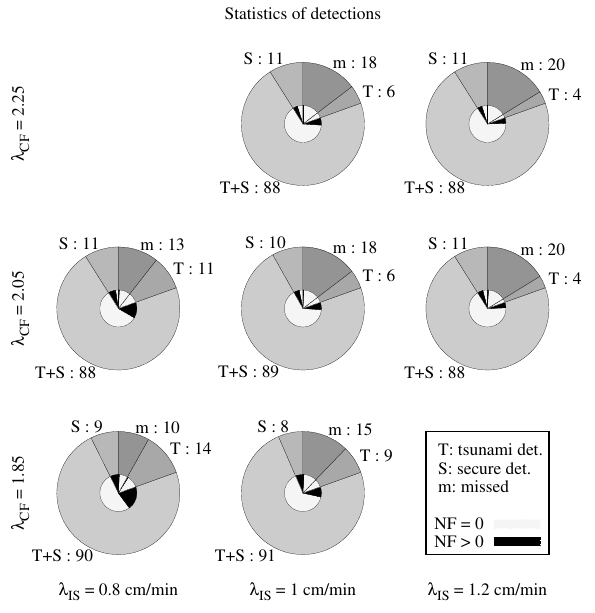
Fig. 10b. Pie charts with statistics of detections within 1-h long TDI. See also the caption of Fig. 10a. Notice how the main difference with a 3-h long TDI is the decrease of secure detection results with the consequent increase of missed records by both the secure and the tsunami modules. Table 4. Configurations of TEDA parameters and thresholds in this work. The fixed TEDA parameters are T IS = 12 min, T BS = 60min, T G = 16min, T SD = 8 min, T A = 60min, and the threshold λ SD = 20 cm, while thresholds λ IS and λ CF vary. The first column gives the number used as identifier. Configuration C4 is the best found for the tide gauge station of Adak Island, USA.